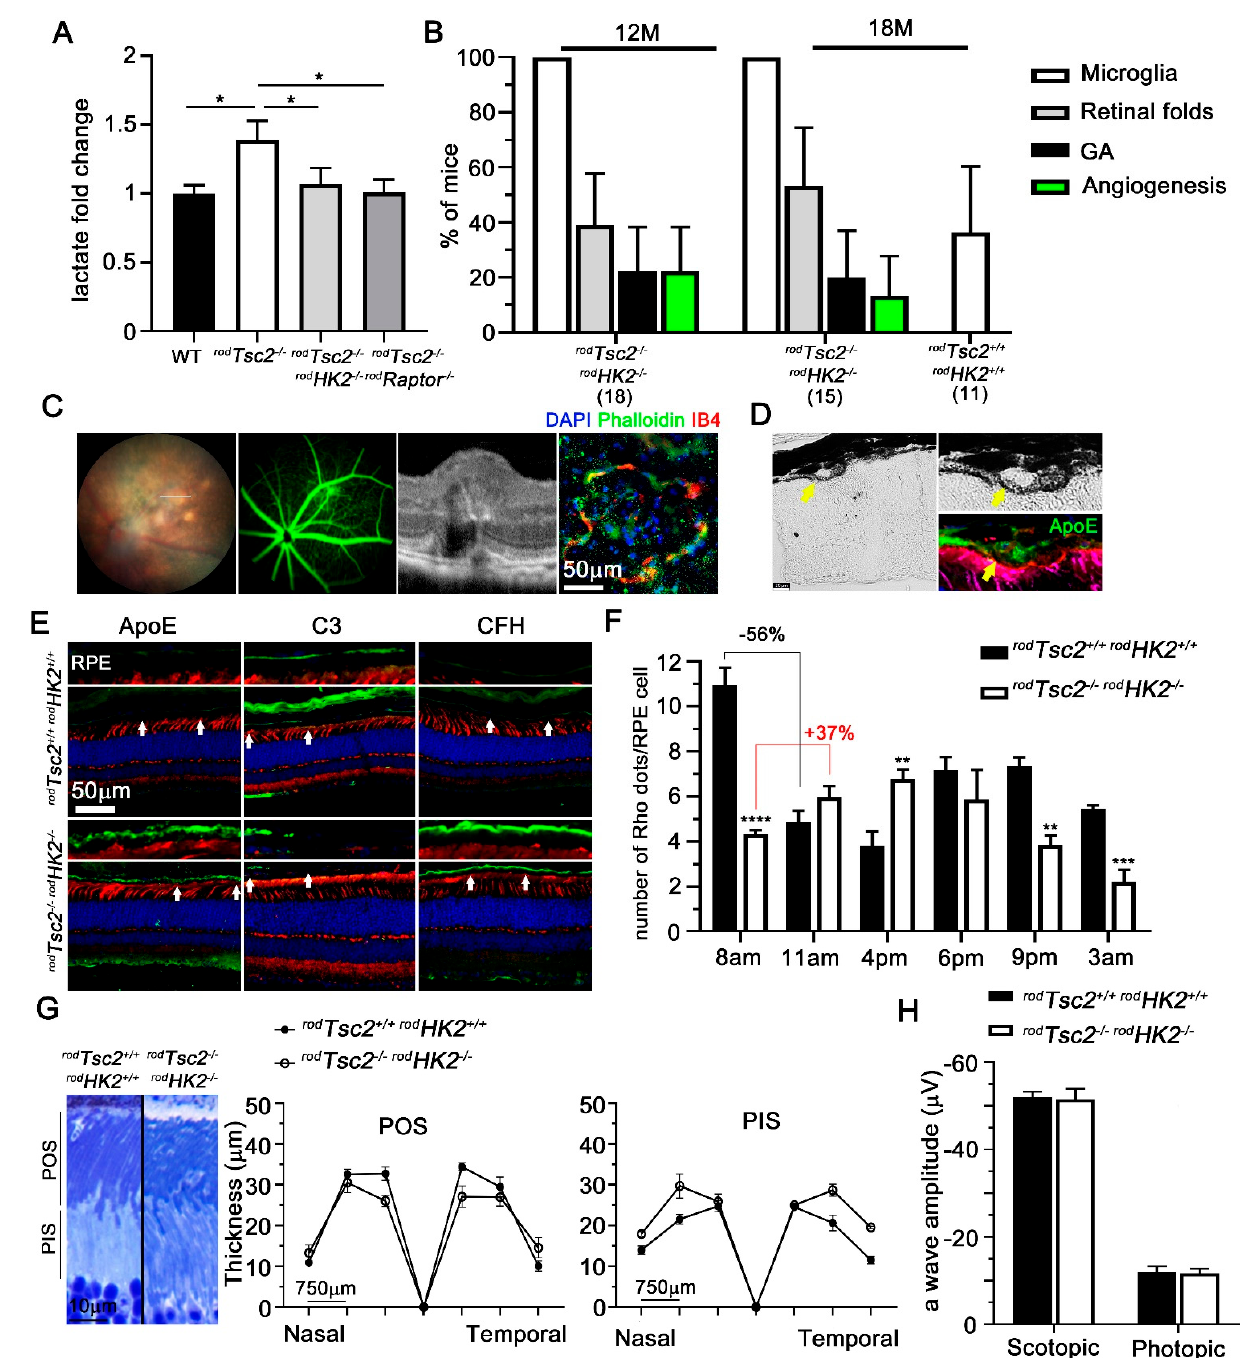
Figure 4. HK2-dependent aerobic glycolysis in PRs is not required for disease development. ( A ) Retinal lactate measurements from total retinal extracts at 2 M of age of genotypes indicated. Each bar shows relative fold change compared with each genotype’s littermate control ±S.E.M. ( n = 4–6 mice, * p < 0.05). ( B ) Quantification of pathologies seen by funduscopy and angiography in rod Tsc2 − / − rod Hk2 − / − mice at 12 M and 18 M of age, and in littermate controls at 18 M of age. Each bar shows percentage of mice ± M.O.E. Number in parentheses represents number of mice analyzed per time point and genotype. ( C ) Analysis of the same GA and CNV lesion seen in rod Tsc2 − / − rod Hk2 − / − mice by fundus, FFA, OCT, and on RPE flat mount (far right). Line in first panel shows region of OCT scan. IB4 staining (red signal) on RPE flat mount marks blood vessels that have protruded through the BrM and RPE layer, while phalloidin marks remaining RPE cells. ( D ) Representative drusen-like deposit in rod Tsc2 − / − rod Hk2 − / − that also stains positive for ApoE (ApoE: green; phalloidin: red, marking RPE cell boundaries; PNA: magenta, marking cone segments). ( E ) Immunofluorescence images of rod Tsc2 +/+ rod Hk2 +/+ (top) and rod Tsc2 − / − rod Hk2 − / − (bottom) mice at 12 M of age showing different AMD-related markers (green): ApoE, C3, CFH,